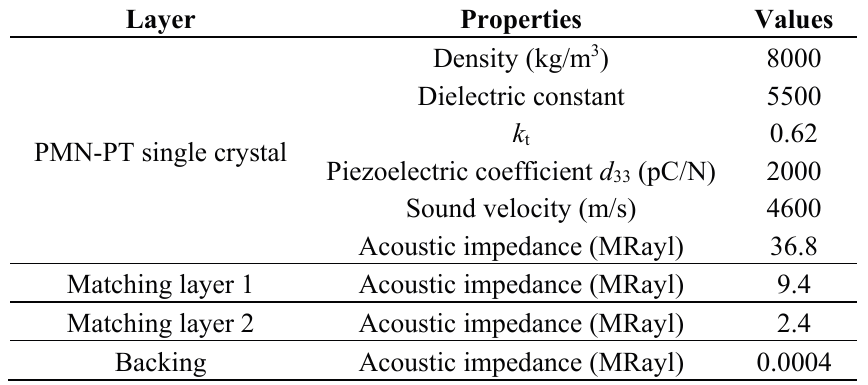
Table 1. Piezoelectric and acoustic properties of the single crystal and